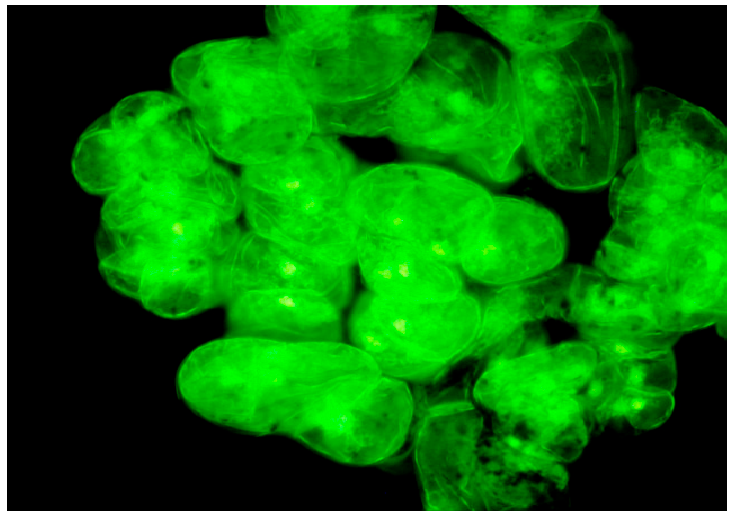
Figure 9. The image of nuclear DNA staining of the cell suspension with the help of DNA-specific fluorochrome acriflavine with acetic hydrolysis (400×).